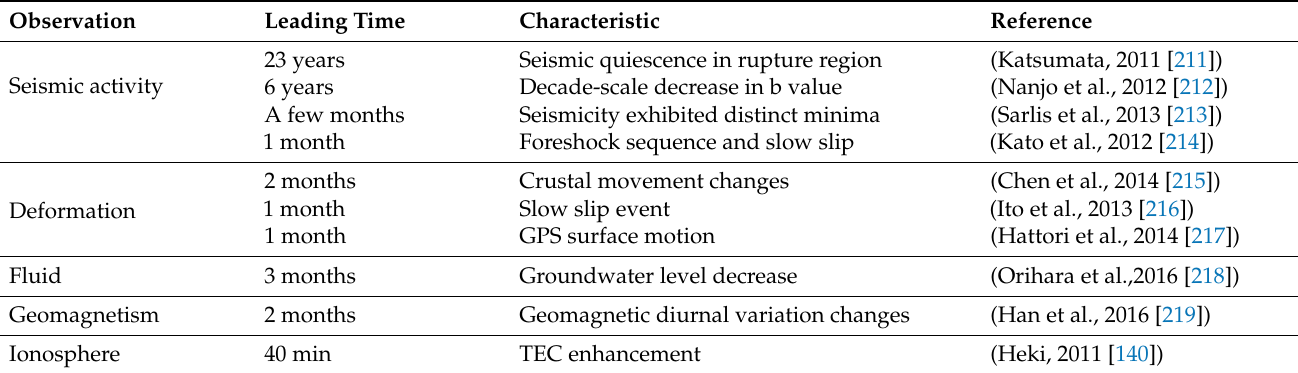
Table 1. Representative precursory characteristics before the 2011 Tohoku